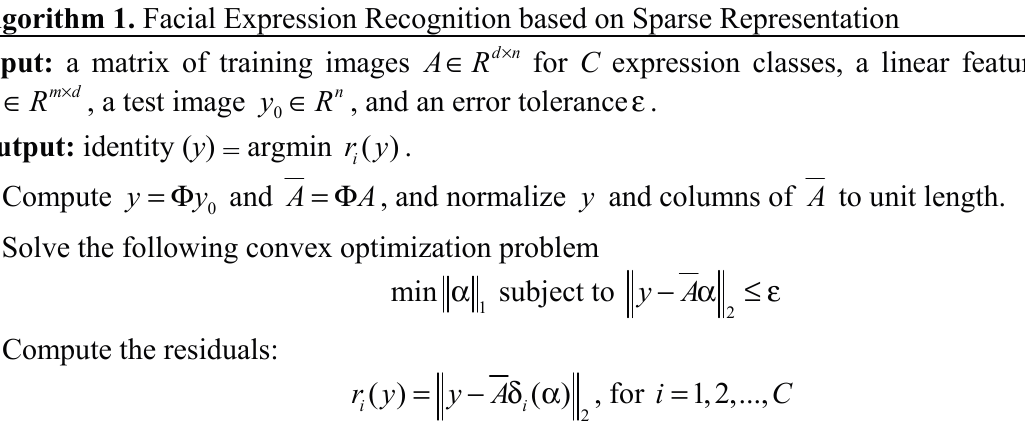
Algorithm 1. Facial Expression Recognition based on Sparse